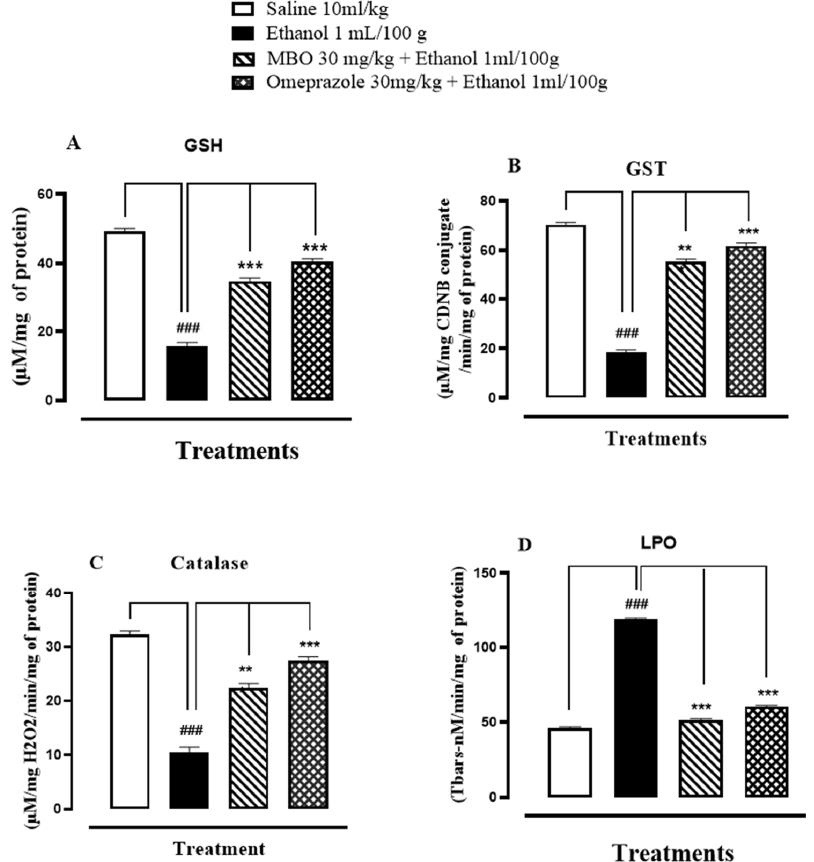
Figure 3. ( A – D ) Bar graph representing the effect of MBO and omeprazole against reduced gluta- thione (GSH), glutathione-s-transferase (GST), catalase and lipid peroxidation (LPO) in ethanol-in- duced gastric ulcer tissues. Values expressed as mean ± SEM ( n = 3). One-way ANOVA, with posthoc Tukey’s test. ### p < 0.001 vs. saline group, *** p < 0.001 vs. ethanol groups.